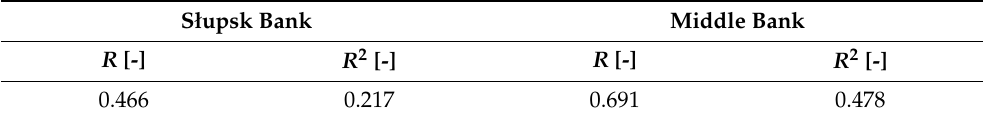
Table 9. Correlation between hourly values.